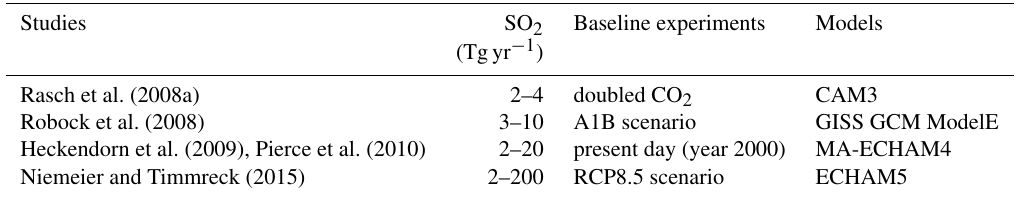
Table 1. Previous studies on simulation of sulfate geoengineering with calculation of stratospheric sulfate aerosols. Injected SO 2 amounts, baseline experiments, and model names are